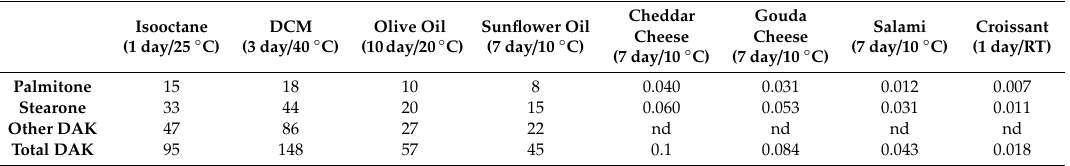
Table 4. Results of solvent extraction and migration test of the dialkylketones (DAK) from paper and board (P&B) sample into food (mg / 6 dm 2 ).